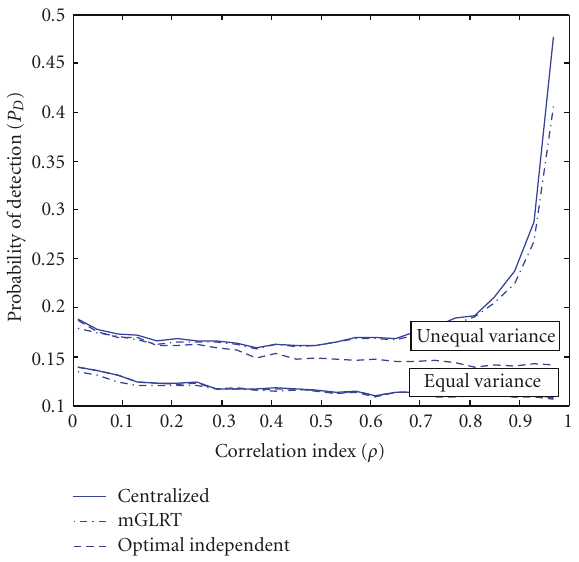
Figure 2: ROC curve of the mGLRT and the optimal independent test for the two-sensor Gaussian example with σ 2 1 = 5, σ 2 2 = 2, σ 2 21 = σ 2 12 = 3, κ i = 0.75, and di ff erent signal amplitudes ( μ = 1,2). Table 1: Simulation details for each figure. Figure